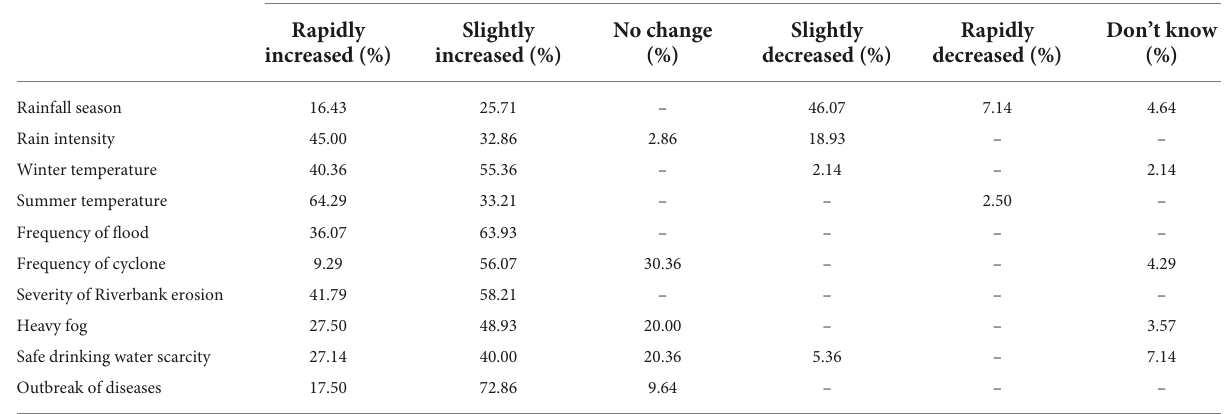
TABLE 3 People perception of climate change in the last 12 years.